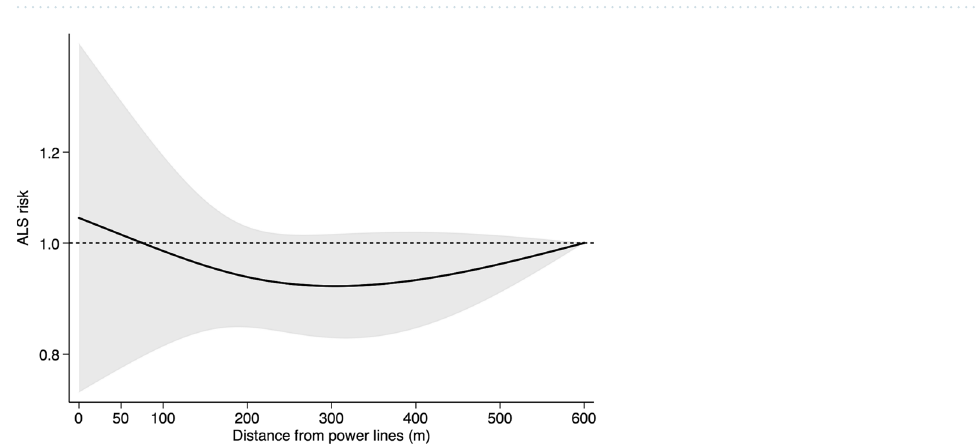
Figure 2. Forest plot with meta-analysis of the highest versus the lowest exposure to magnetic field, using both distance-based or modelling based-methods.